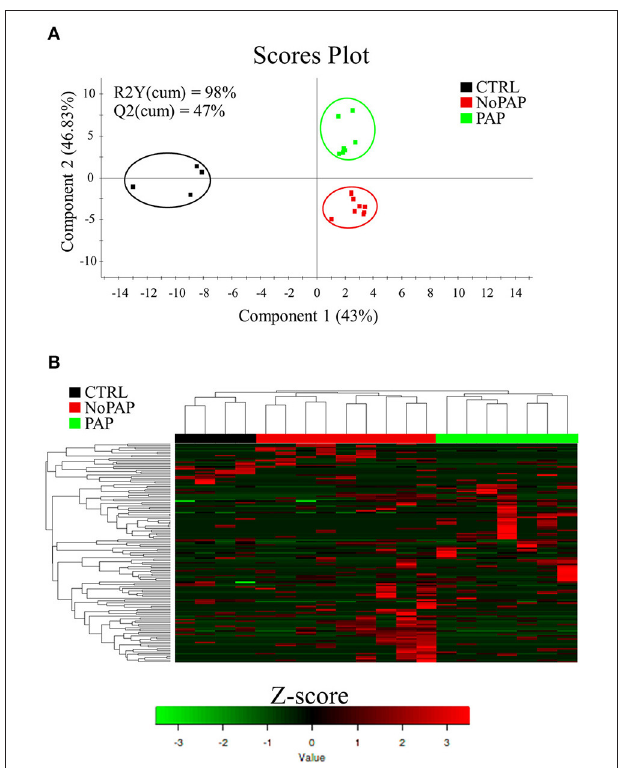
FIGURE 3 | (A) Two-dimensional partial least-squares discriminant analysis (PLS-DA) score plot constructed using the variable diet representing the distribution of the samples between the first two components in the model. The validation by permutation test can be found in Supplementary Figure 3 . (B) Heatmap representing the abundance distribution (Z-score) of the OTUs identified to drive the separation by diet (VIP ≥